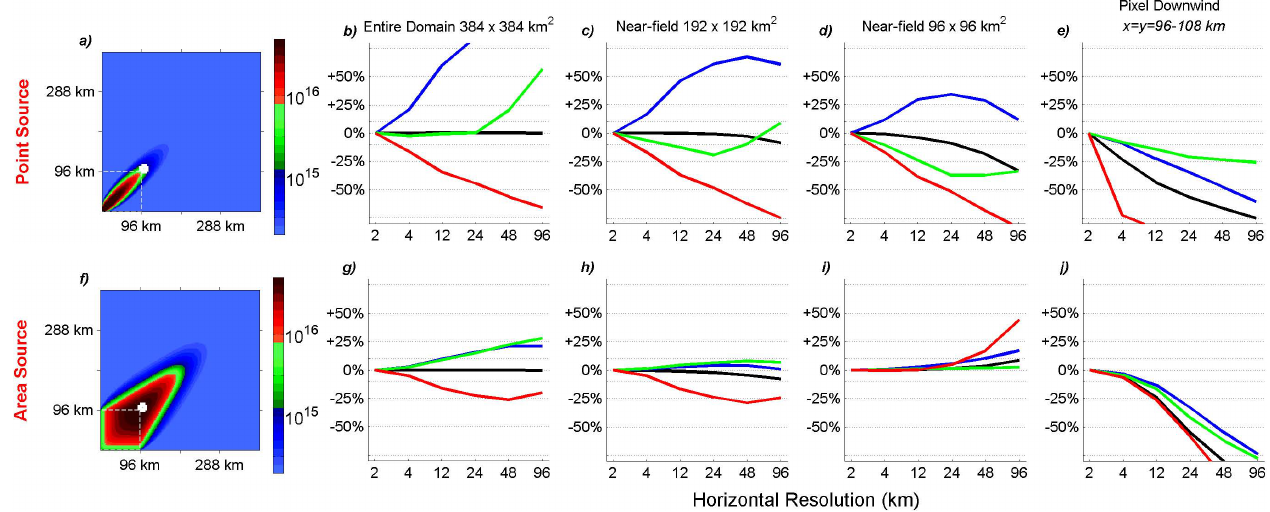
Fig. 5. (a) NO 2 column (moleculescm − 2 ) predicted in a 2-D plume model for a large point source simulated at 2km resolution with vertical layer fixed at 1km thickness. Resolution-dependent bias in domain-averaged NO 2 column over the (b) entire domain ( x = y = 0–384km), (c) the 192km near-field ( x = y = 0–192km), (d) the 96km near-field ( x = y = 0–96km), and (e) at a pixel downwind ( x = y = 96–108) for NO 2 emitted from a large (red), an intermediate (green), and a small (blue) point source of NO 2 with OH = f NO large point source with OH set to 5 × 10 6 moleculescm − 3 (black). (f–j) The same for simulation of a 96 × 96km 2 area